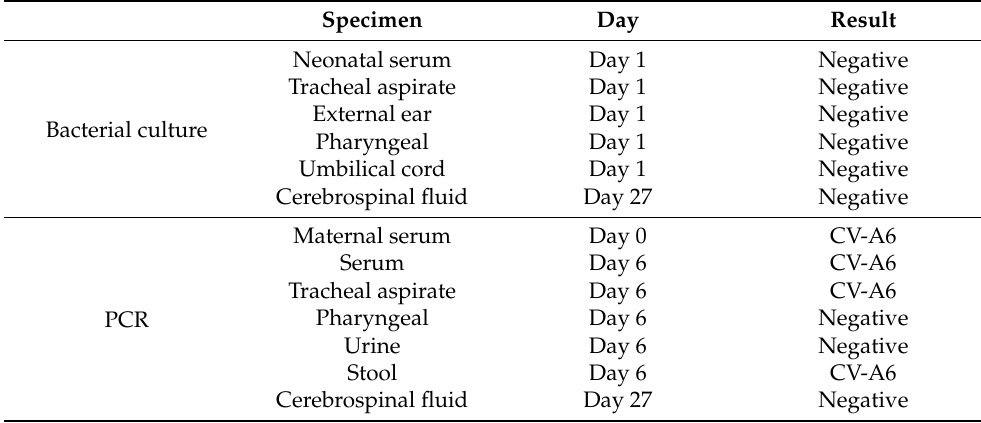
Table 2. Bacterial and viral examination results.